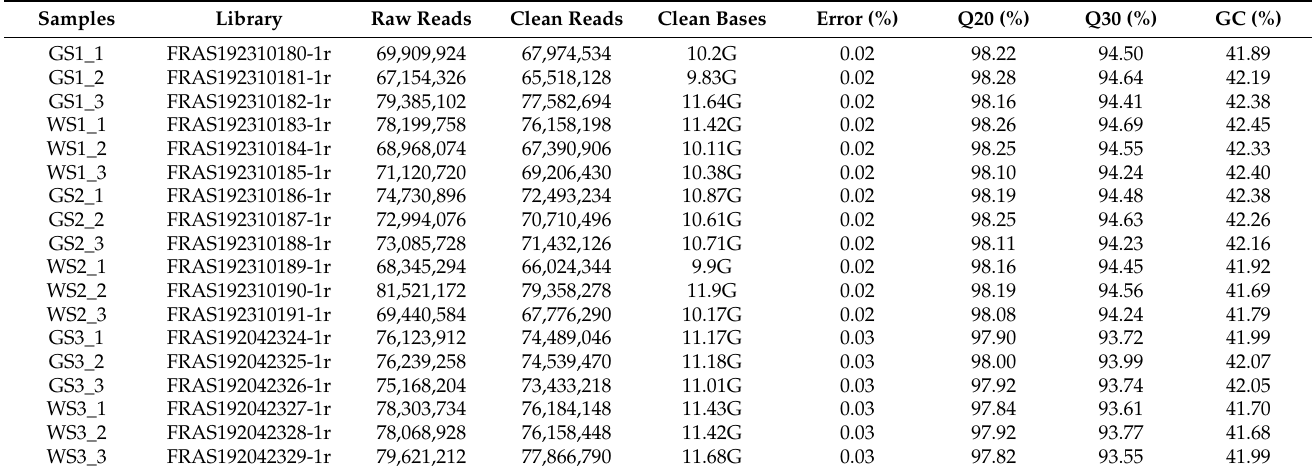
Table 1. Summary of transcriptome sequencing data and transcriptome assembly.